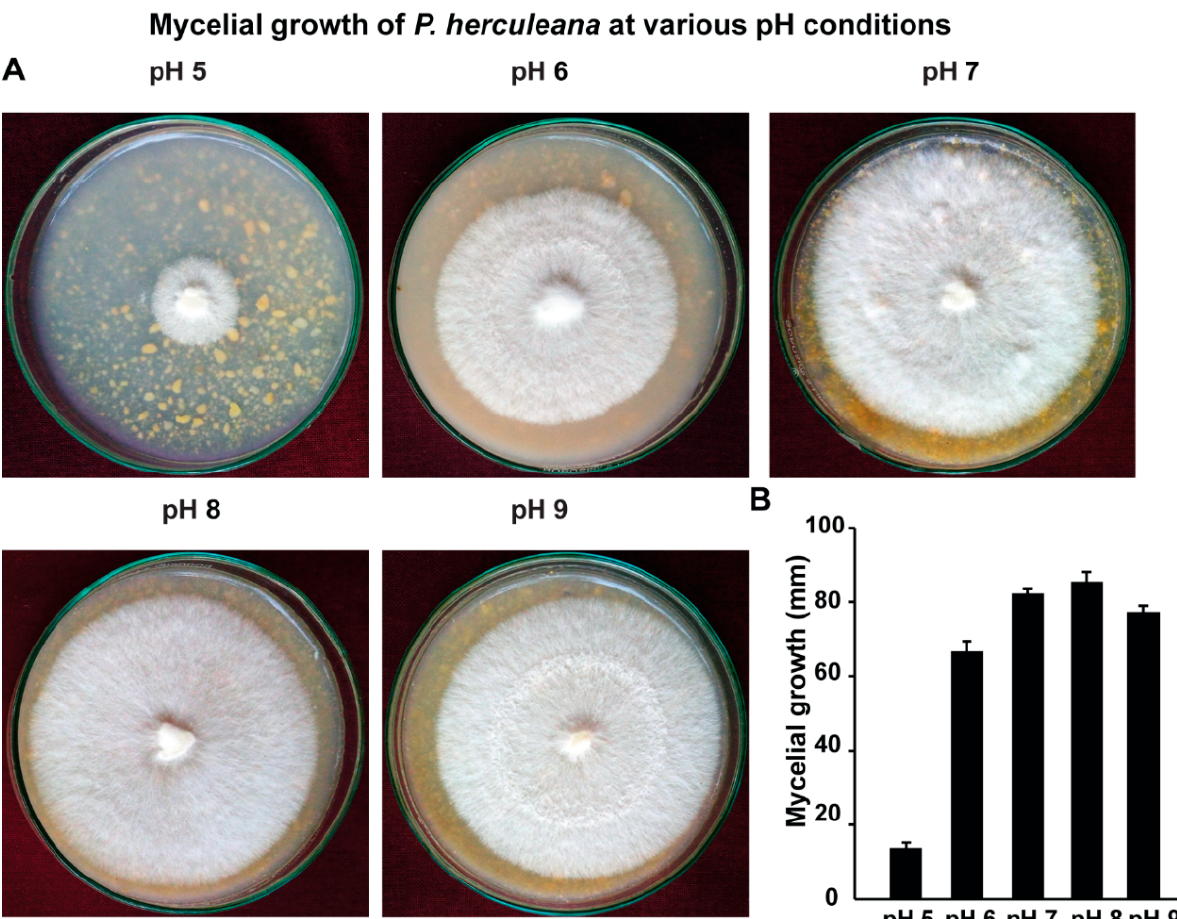
Figure 4. Mycelial growth of Phellorinia herculeana at various temperature conditions. ( A ): Mycelial growth of P. herculeana on maize agar medium incubated at different temperature conditions; ( B ): The radial growth of P. herculeana , grown at different temperature conditions, was measured in mil- limeter. Error bar indicates the standard deviations.